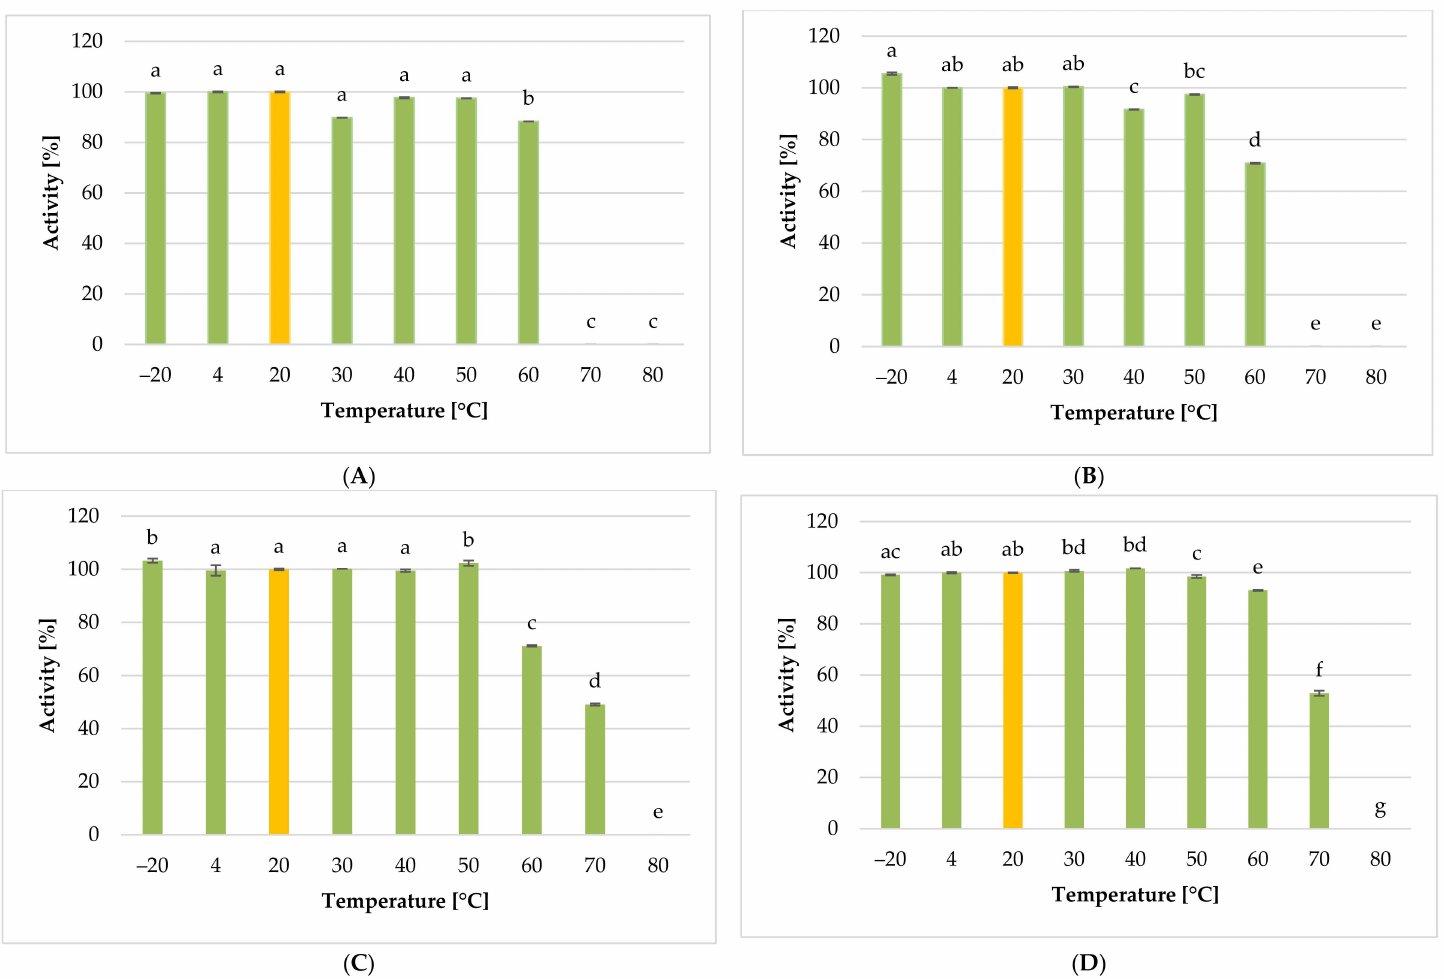
Figure 14. The activity of phages against tested bacterial strains at selected temperature values: ( A ) Citrobacter phage KKP 3664, ( B ) Enterobacter phage KKP 3262, ( C ) Enterobacter phage KKP 3263, ( D ) Serratia phage KKP 3264. Letters a, b, c, d, e, f, g in superscript indicate homogenous groups at a significance level of p < 0.05, n =